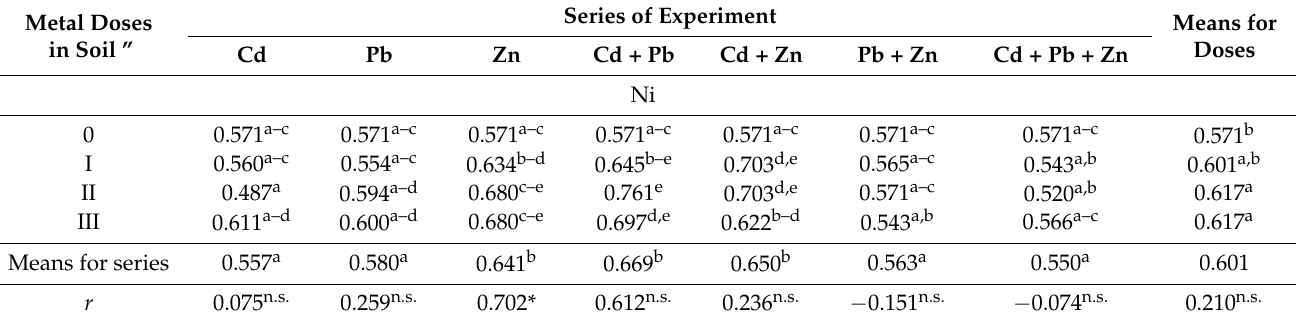
Table 3. Content of available forms of Ni, Cr and Co, in mg kg − 1 of